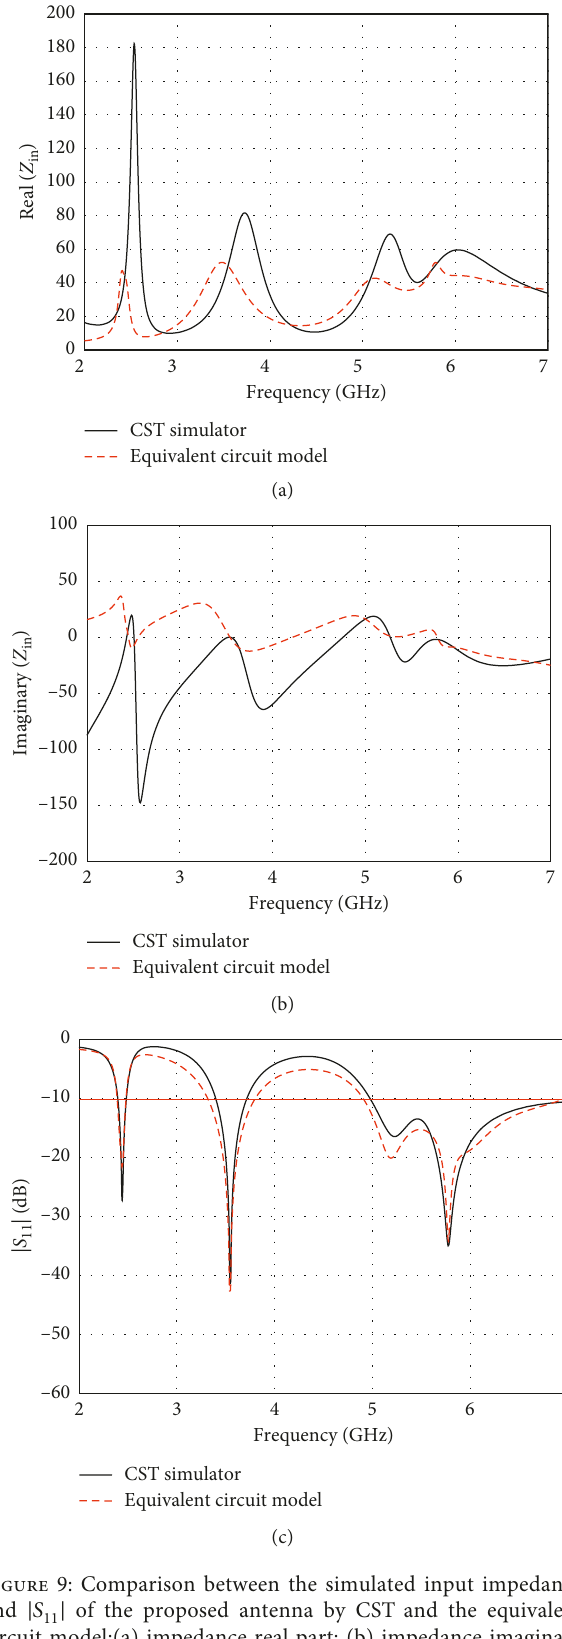
Figure 9: Comparison between the simulated input impedance | of the proposed antenna by CST and the equivalent and | S 11 circuit model:(a) impedance real part; (b) impedance imaginary | part; (c) | S 11